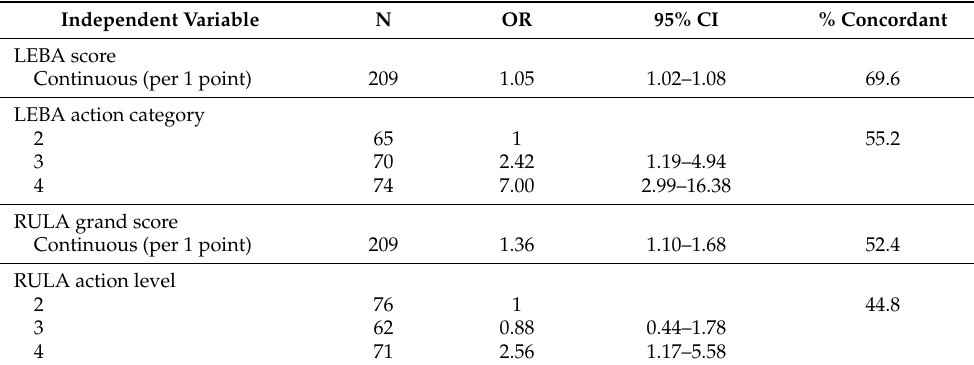
Table 5. Results of logistic regression